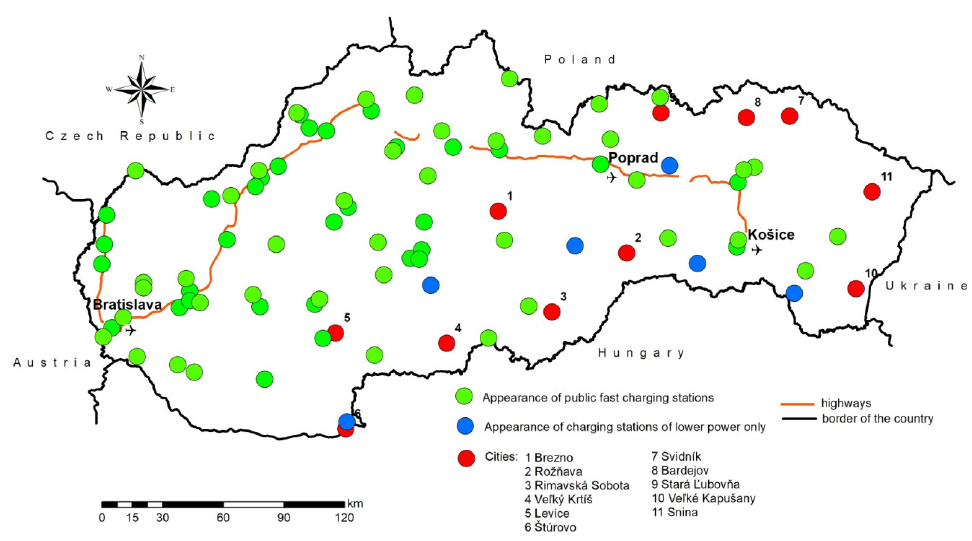
Figure 7. Localization of public fast charging stations in Slovakia in 2020.